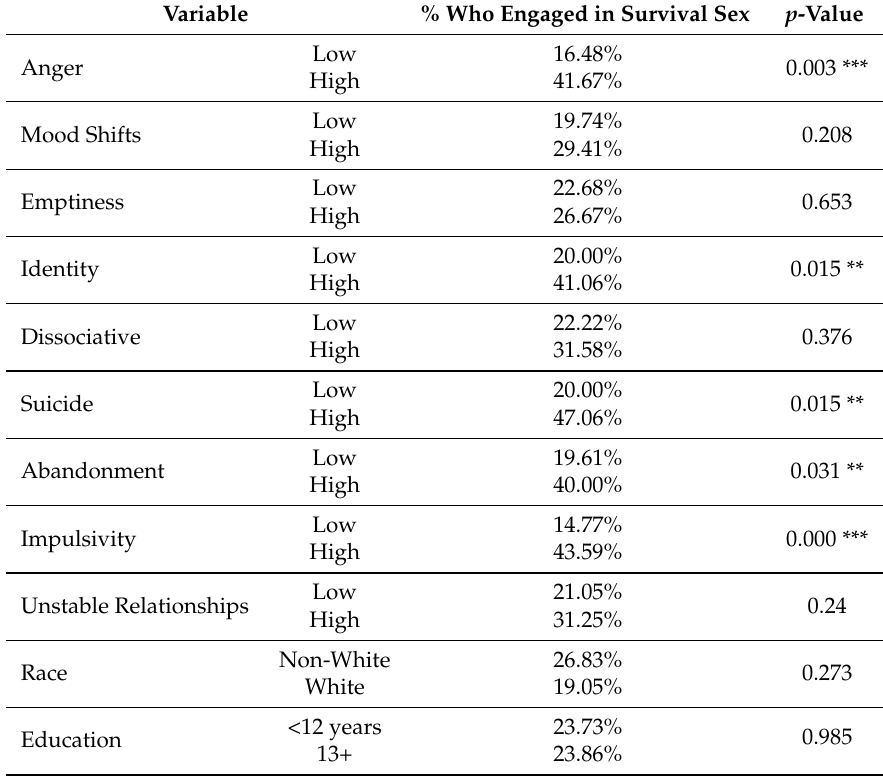
Table 2. Crosstabs between survival sex and categorical independent variables (n =